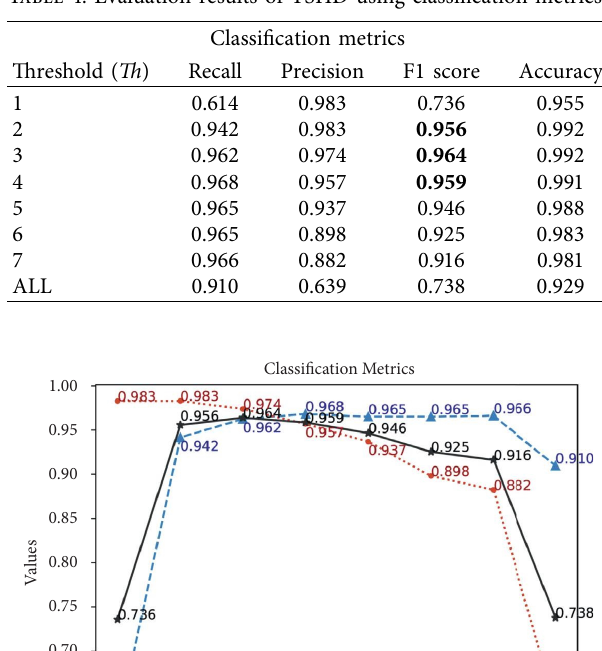
Table 4: Evaluation results of TSHD using classifcation metrics.